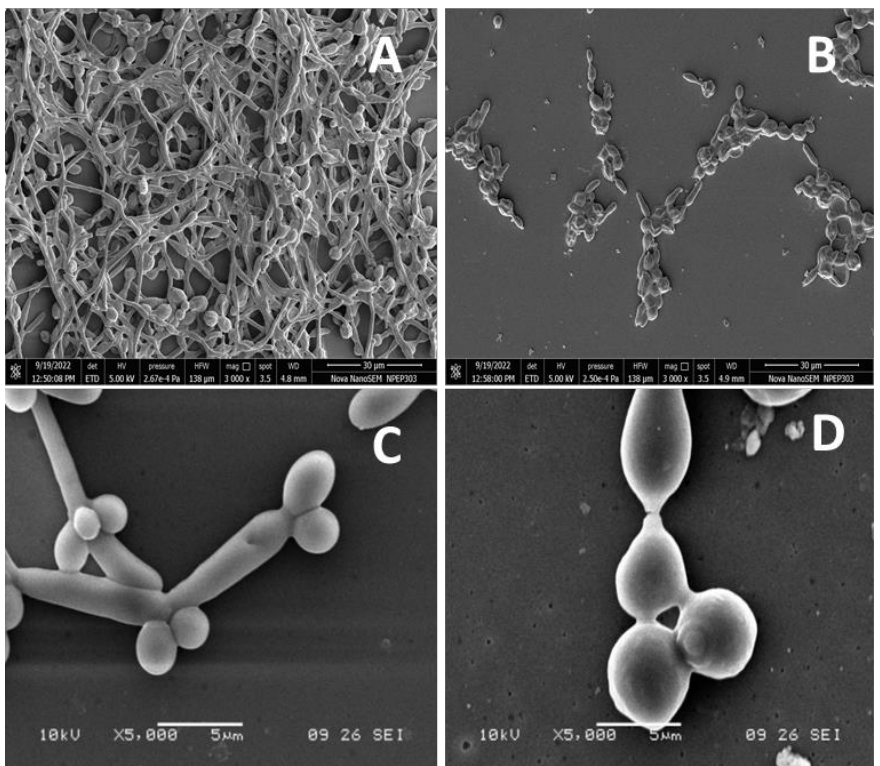
Figure 6. The anti-morphogenesis activity of SeNP@PVP_Nystatin nanoconjugates. Nanoconjugates